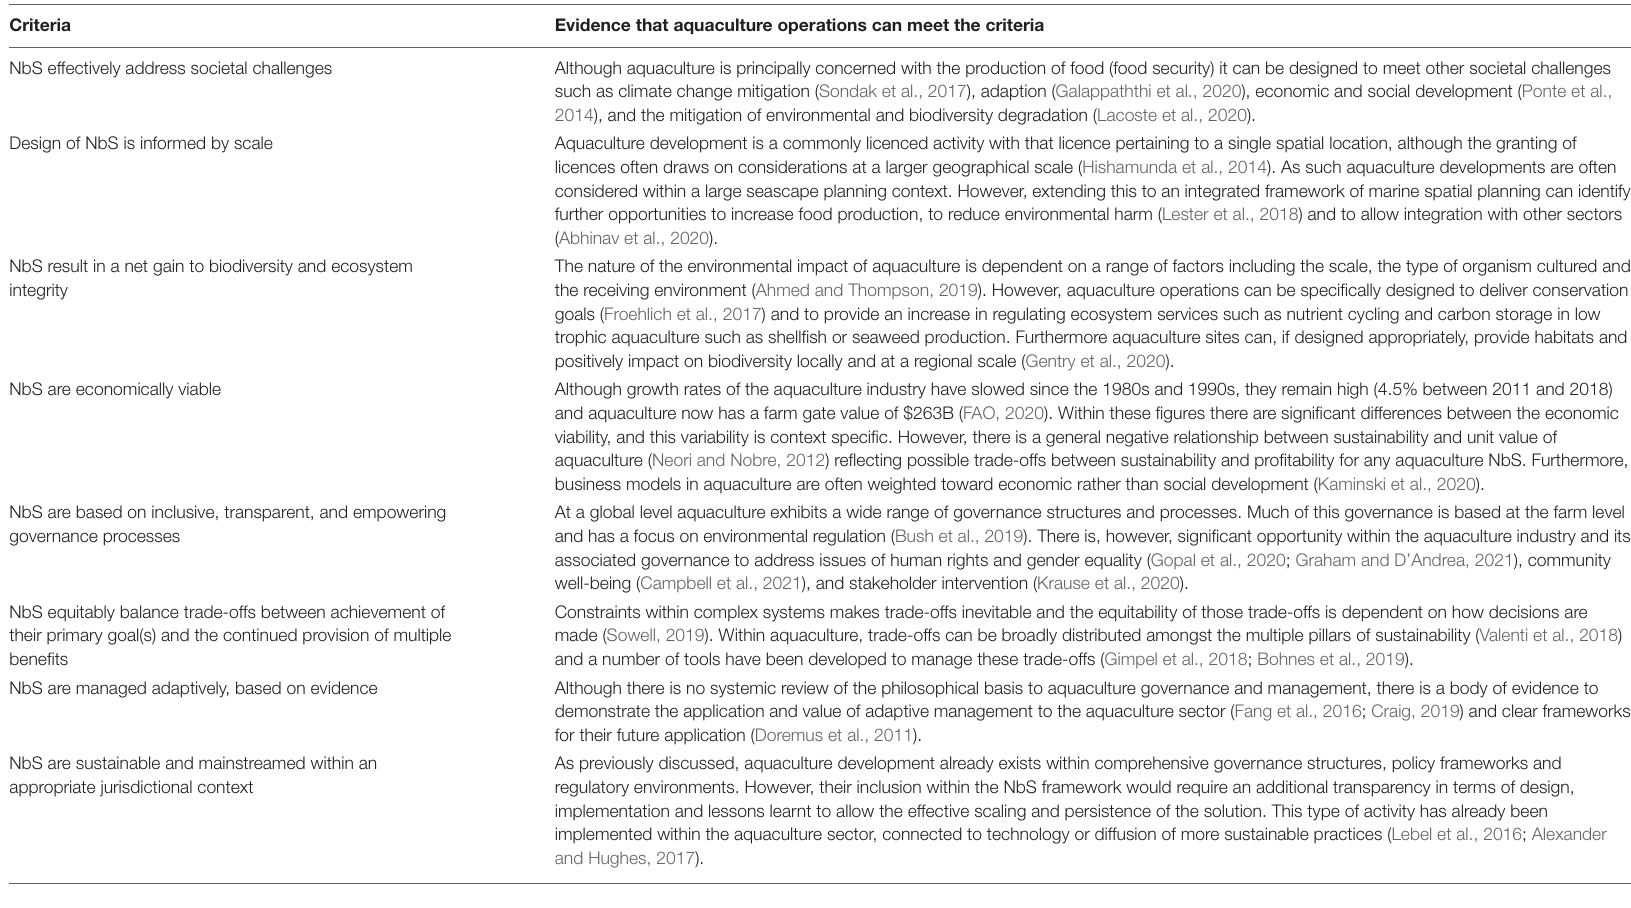
TABLE 1 | The eight criteria as developed by the IUCN global standard for Nature-based Solutions (IUCN, 2020) and evidence to demonstrate how specific, planned aquaculture activities meet the